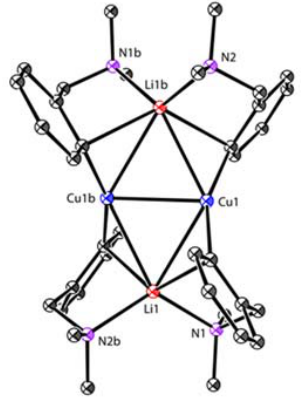
Scheme 7. Neutral C,N-bidentate organocuprates [65–69].